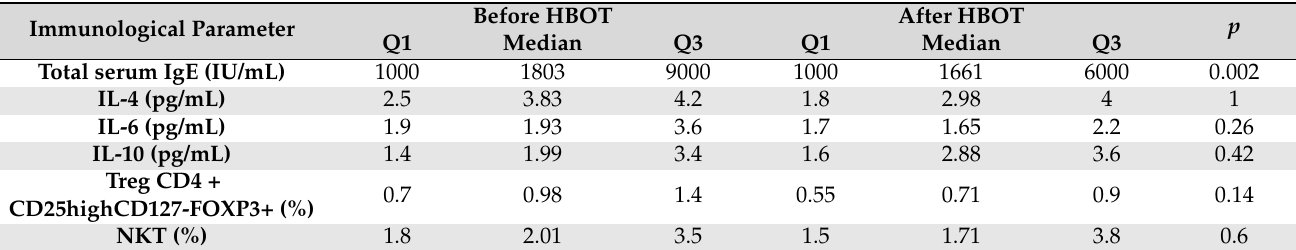
Table 4. Effect of the HBOT on immunological parameters (measured in the blood serum). Before HBOT After HBOT Immunological Parameter